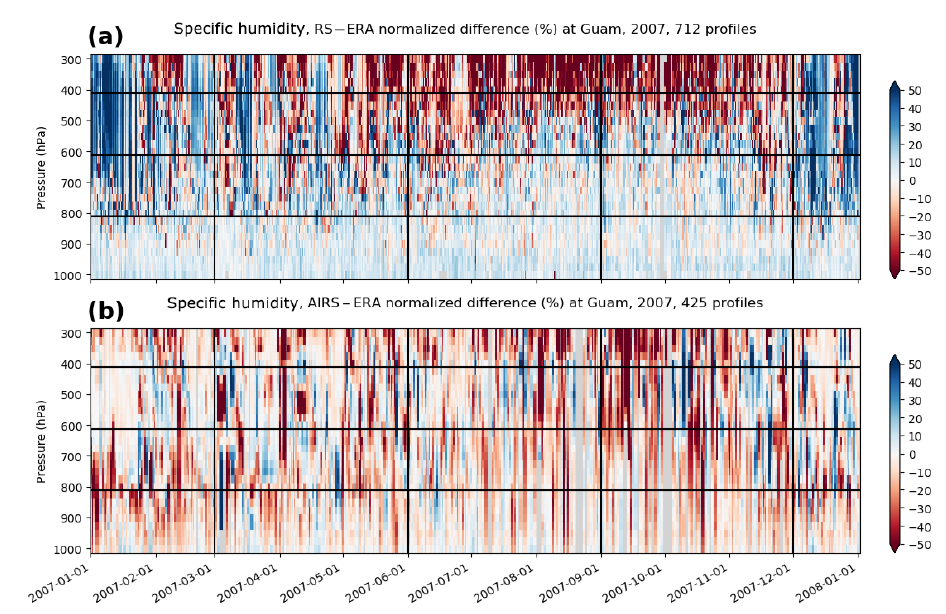
Figure 4. 2007 time series of the q normalized difference between (a) RS and ERA, and between (b) AIRS and ERA at Guam. The color bar on the right indicates specific-humidity normalized differences